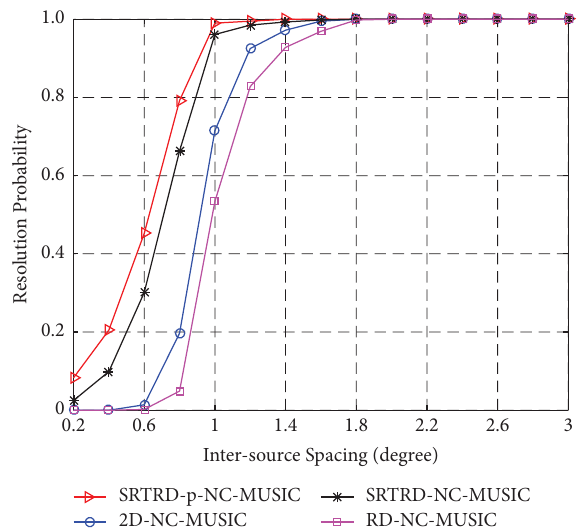
Figure 11: Resolution probability comparison versus diferent intersource spacing Δ θ , SNR � 0dB and L � 500.